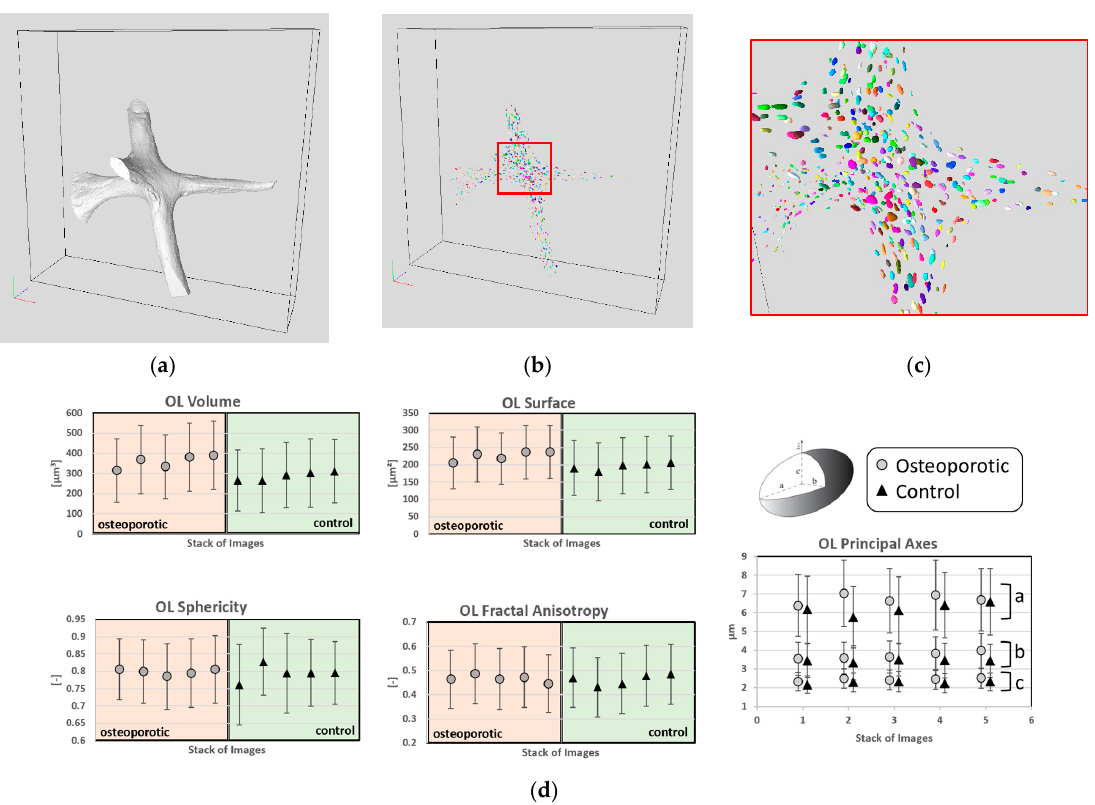
Figure 5. Osteocytes lacunae characteristics. “OL” refers to osteocytes lacunae. ( a ) morphology of a single trabecula, ( b ) visualization of the osteocytes lacunae embedded in the trabecula showed in ( a ), ( c ) magnification of the osteocytes lacunae in the center of ( b , d ) morphological analysis showing the volume, the surface, the sphericity, the fractal anisotropy and the principal axes computed from the osteocytes lacunae embedded in the solid bone of both the osteoporotic and the control sample.